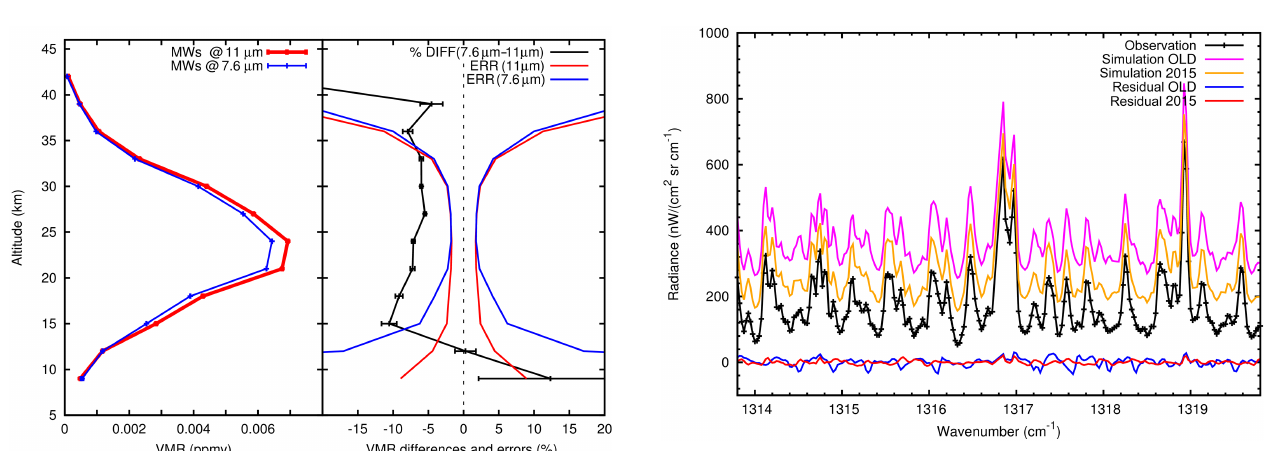
Figure 2. Left panel: average HNO 3 VMR profiles from MIPAS measurements acquired on 24 January 2003, using the MIPAS-OLD linelist. Retrievals using MWs in the 11µm region (red line) and in the 7.6µm region (blue line). Right panel: mean percentage differ- ences between HNO 3 profiles retrieved from the 7.6 and 11µm re- gions (black line). The red and the blue lines show the noise error of the individual retrievals using MWs in the 11 and in the 7.6µm spectral regions.